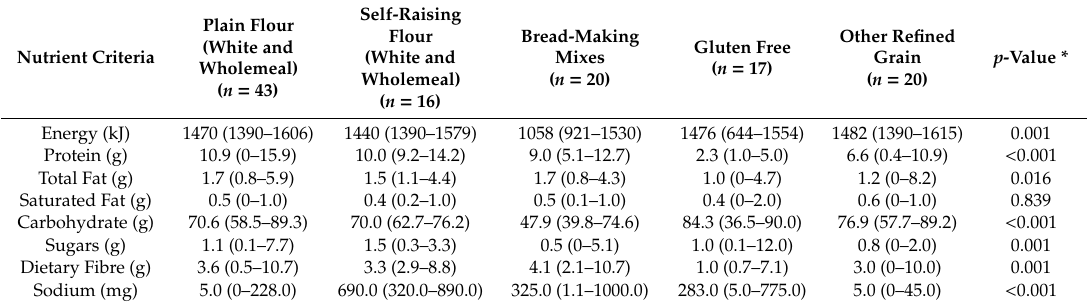
Table 2. Nutrient composition of the main flour categories per 100 g (median and range).